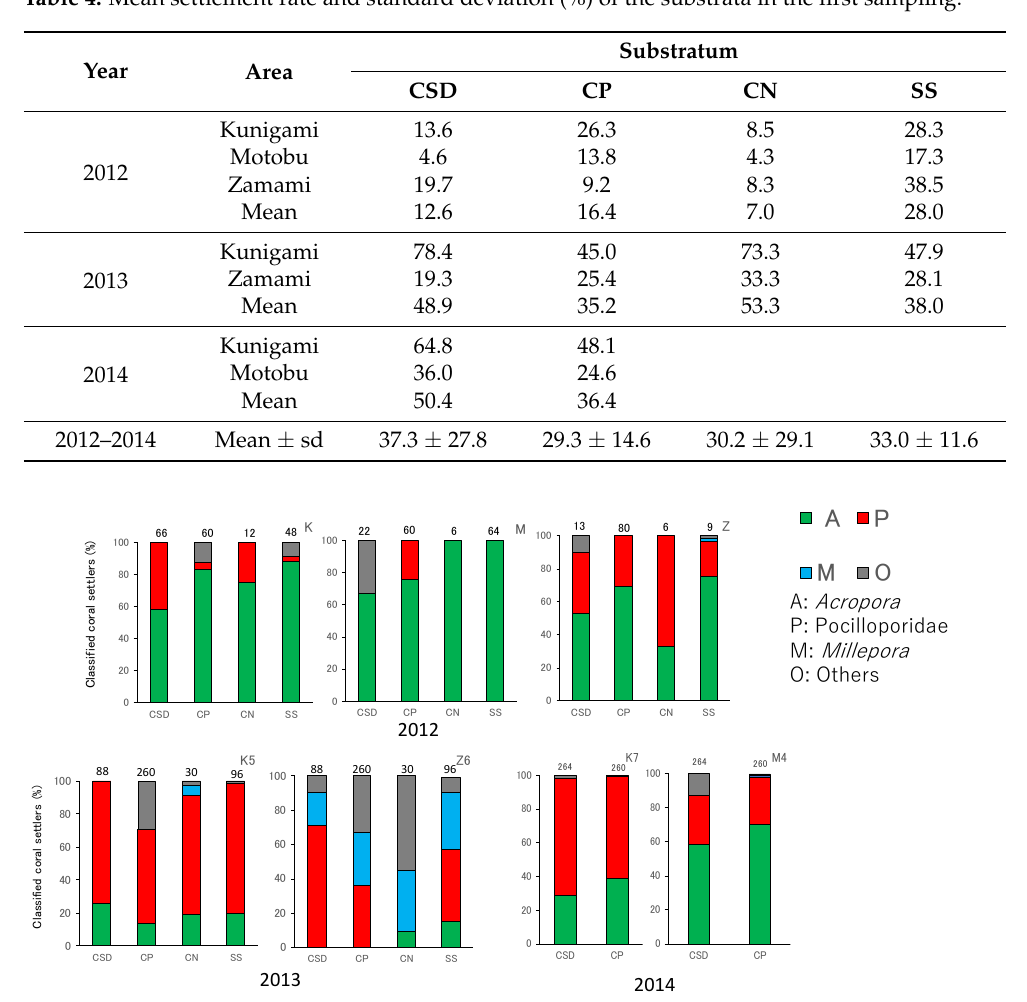
Table 4. Mean settlement rate and standard deviation (%) of the substrata in the first sampling.